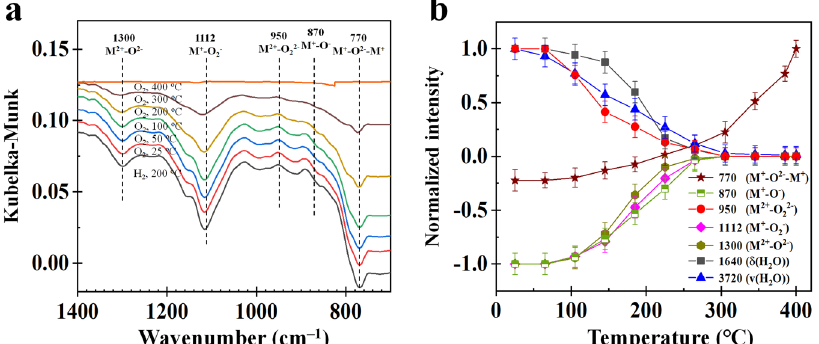
Fig. 5 Experimental results of the regeneration of H 2 -reduced β -MnO 2 in O 2 /Ar at various temperatures. a DRIFTS spectra. b normalized intensities where the error bars are the standard deviations obtained by measuring the peak heights more than three